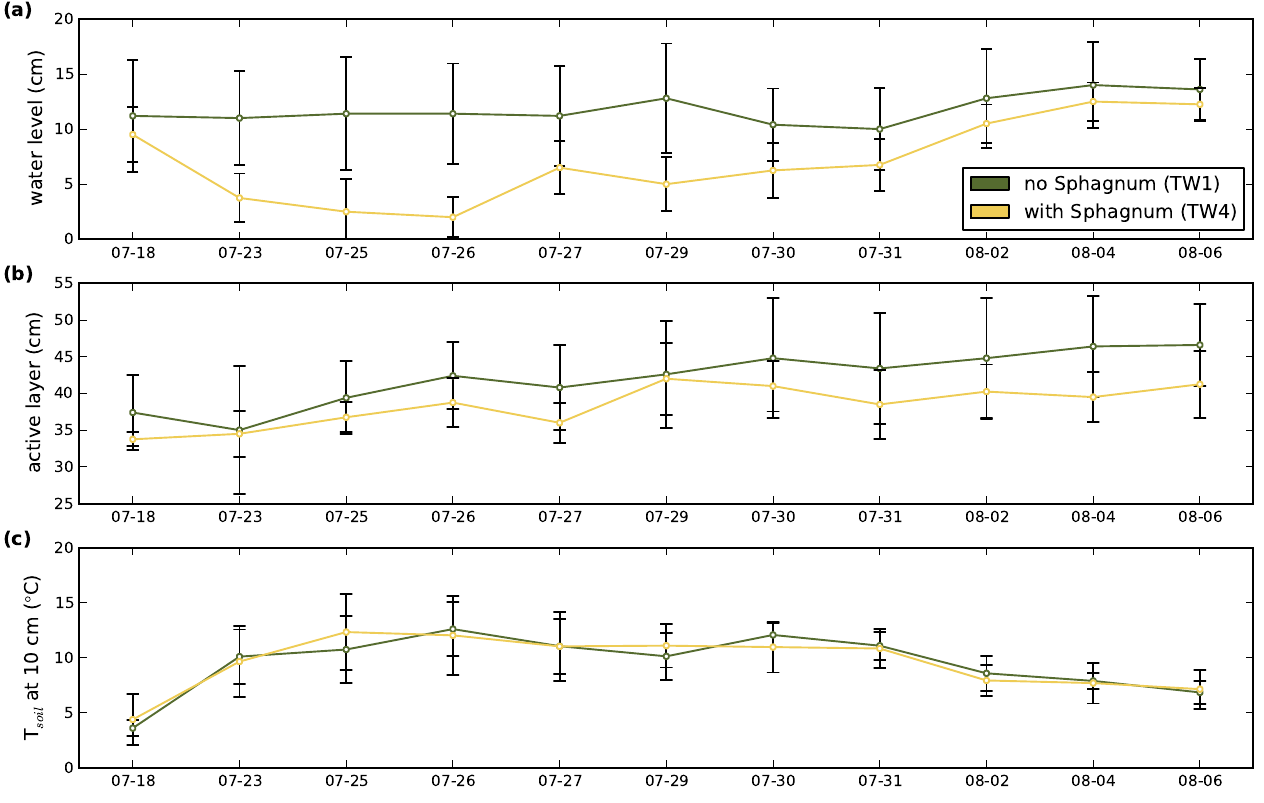
Fig. 2. Environmental parameters during the measurement campaign for the two vegetation types. Dark grey shows the data for the vegetation type without Sphagnum , TW1, while the data for the vegetation type with Sphagnum , TW4, is shown in light grey. Error bars denote standard deviations. (a) Daily water level above the surface. (b) Active layer thickness. (c) Daily soil temperature at 10cm depth.